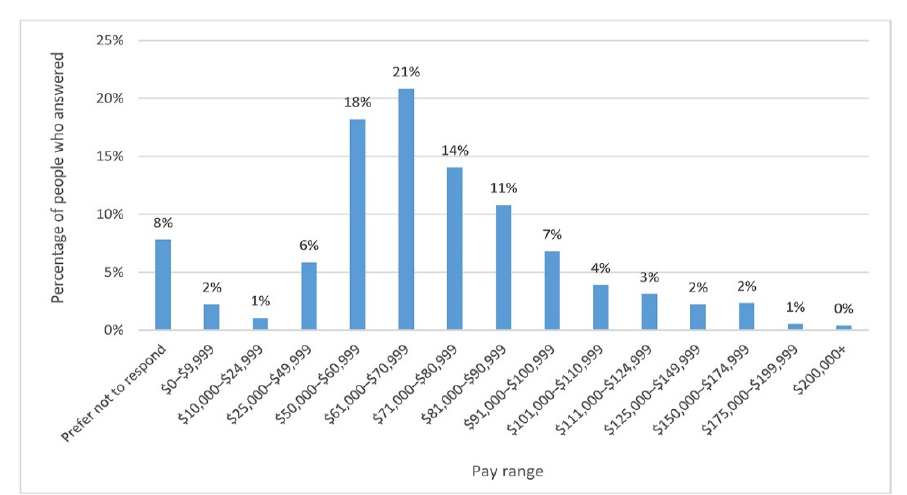
Figure 9 Pay range by